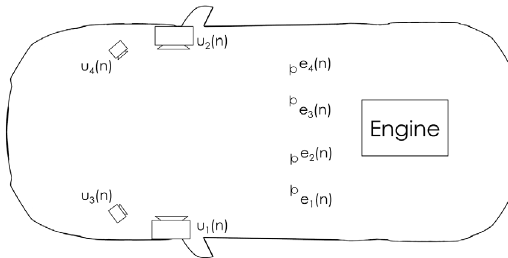
Figure 1. Actual scheme and positioning of the control system (microphones and loudspeakers) in the car cabin.